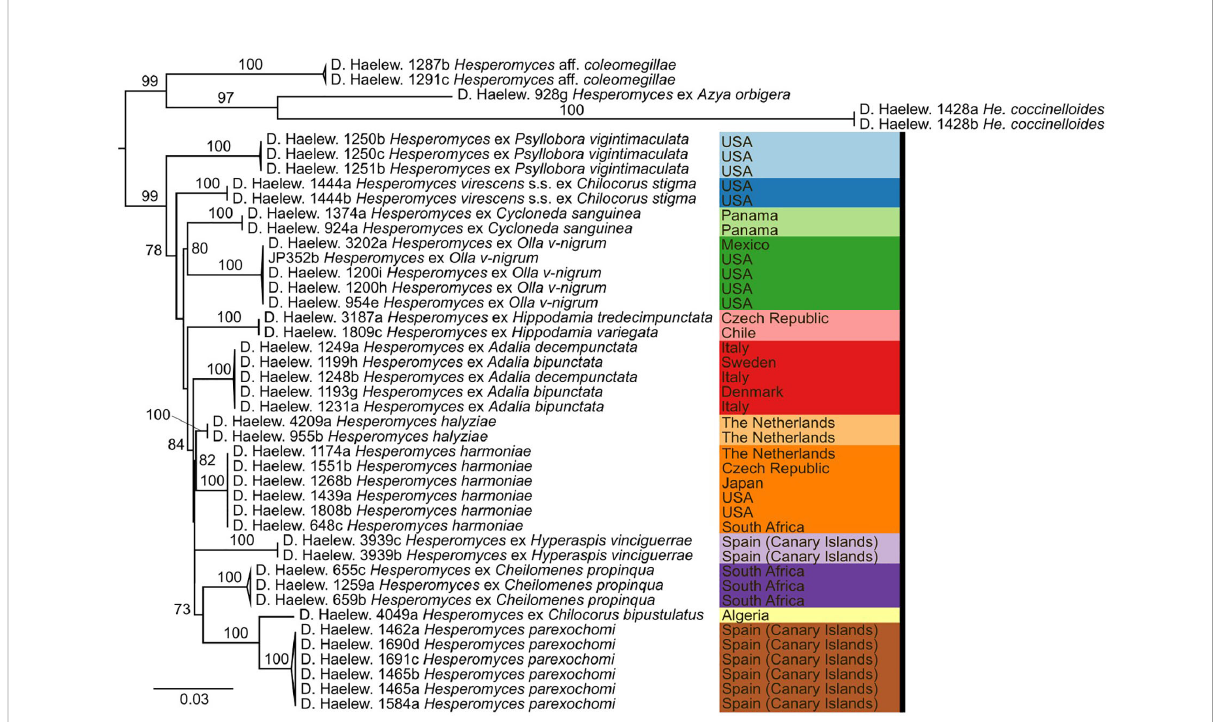
FIGURE 1 Phylogenetic tree obtained from the maximum likelihood (ML) analysis of a three-locus (ITS – LSU – MCM7 ) dataset. For every node, the ML bootstrap value ( ≥ 70) is given above or next to the branch leading to that node. Species within the Hesperomyces virescens complex are each indicated with their own color. Color scheme from https://colorbrewer2.org by C.A. Brewer, Geography, Pennsylvania State